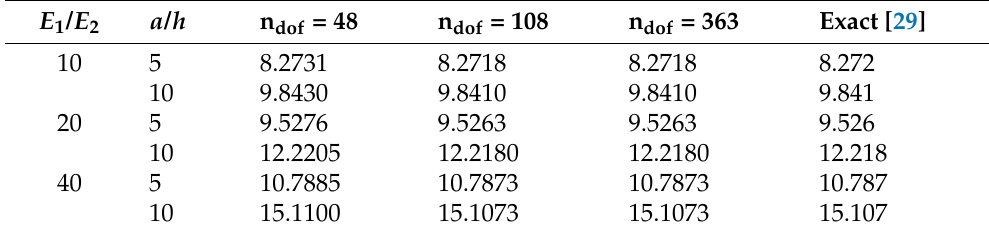
Table 2. Frequency parameter ω 1 for straight-fiber plates: comparison with